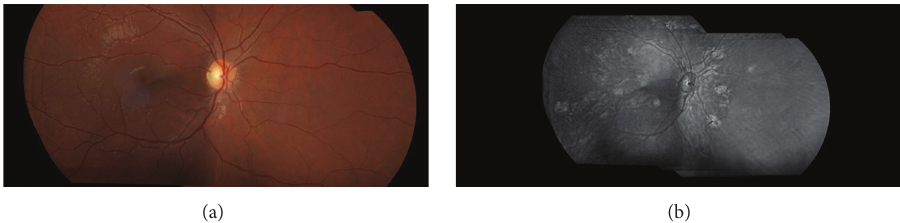
Figure 3: Color fundus photograph (a) and near infrared reflectance fundus image (b) in a patient with NF1. Patchy and rounded choroidal alterations are most apparent on infrared reflectance